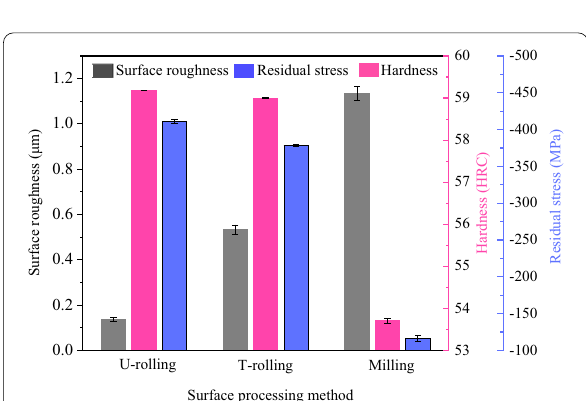
Figure 6 Effect of U-rolling on surface quality of cladding